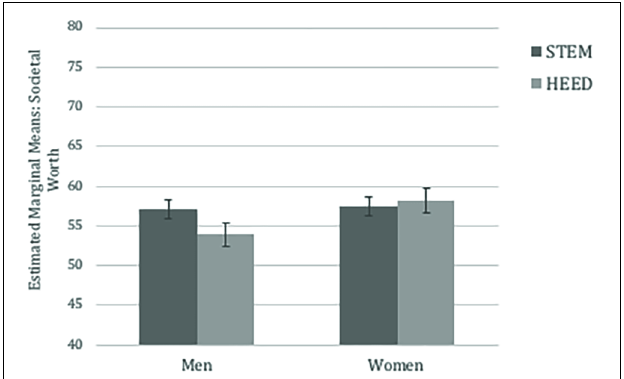
FIGURE 7 | Study 3 perceived societal worth of HEED and STEM by participants gender. Error bars represent standard errors of the mean. Graphed means are marginal estimates accounting for perceived pay and work hours in both occupation